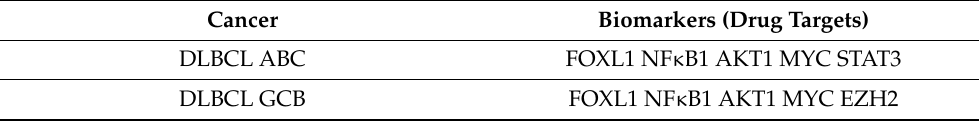
Table 1. The biomarkers (drug targets) are identified for DLBCL ABC and DLBCL GCB.